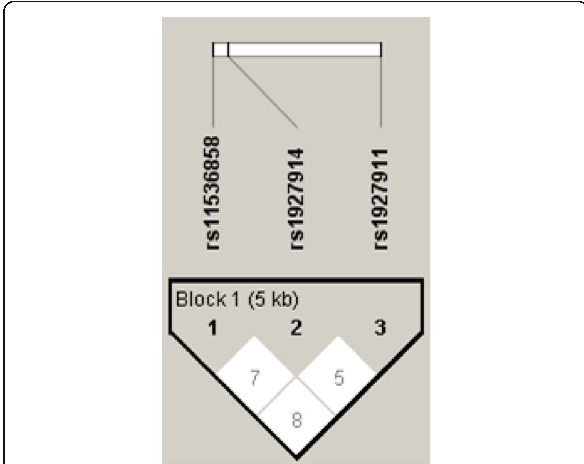
Fig. 2 Linkage disequilibrium (LD) for the selected SNPs in cases and controls (using Haploview software analysis) [10]. The colored squares represent the numerical estimation of D ′ value. The D ′ value for LD between rs1536858 and rs1927914 was 0.071, between rs1536858 and rs1927911 was 0.089, and between rs1927914 and rs1927911 was 0.051